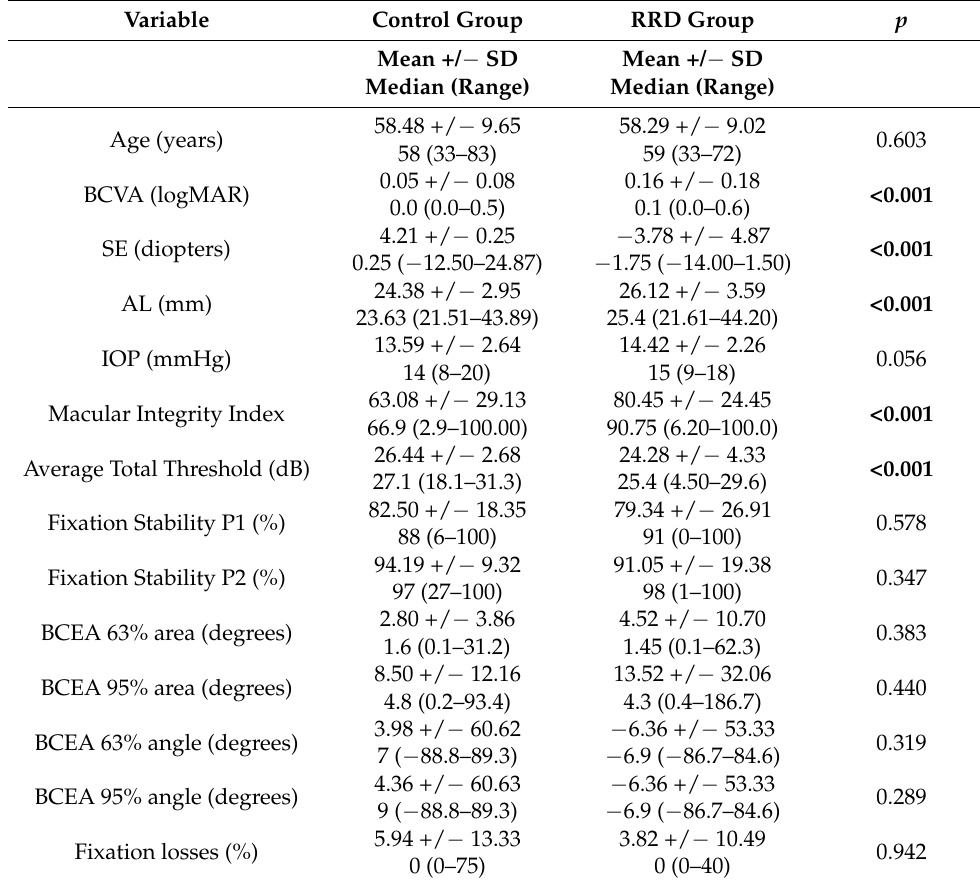
Table 1. Clinical characteristics of both groups. Significant differences ( p < 0.05) are highlighted in bold